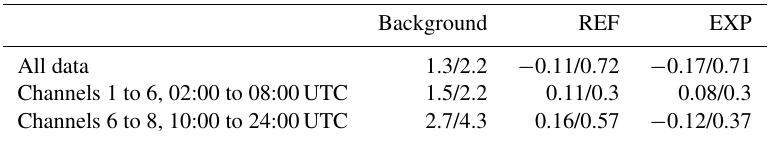
Table 2. Bias/RMSE (K) of the background and analyses produced by EXP and REF against MWR TB observations. Statistics are computed either using all data or restricted to channels 1 to 5 between 02:00 and 08:00UTC or channels 7 to 9 between 10:00 and 24:00UTC (these two sub-samplings are represented by the dashed rectangular boxes in Fig. 5b and